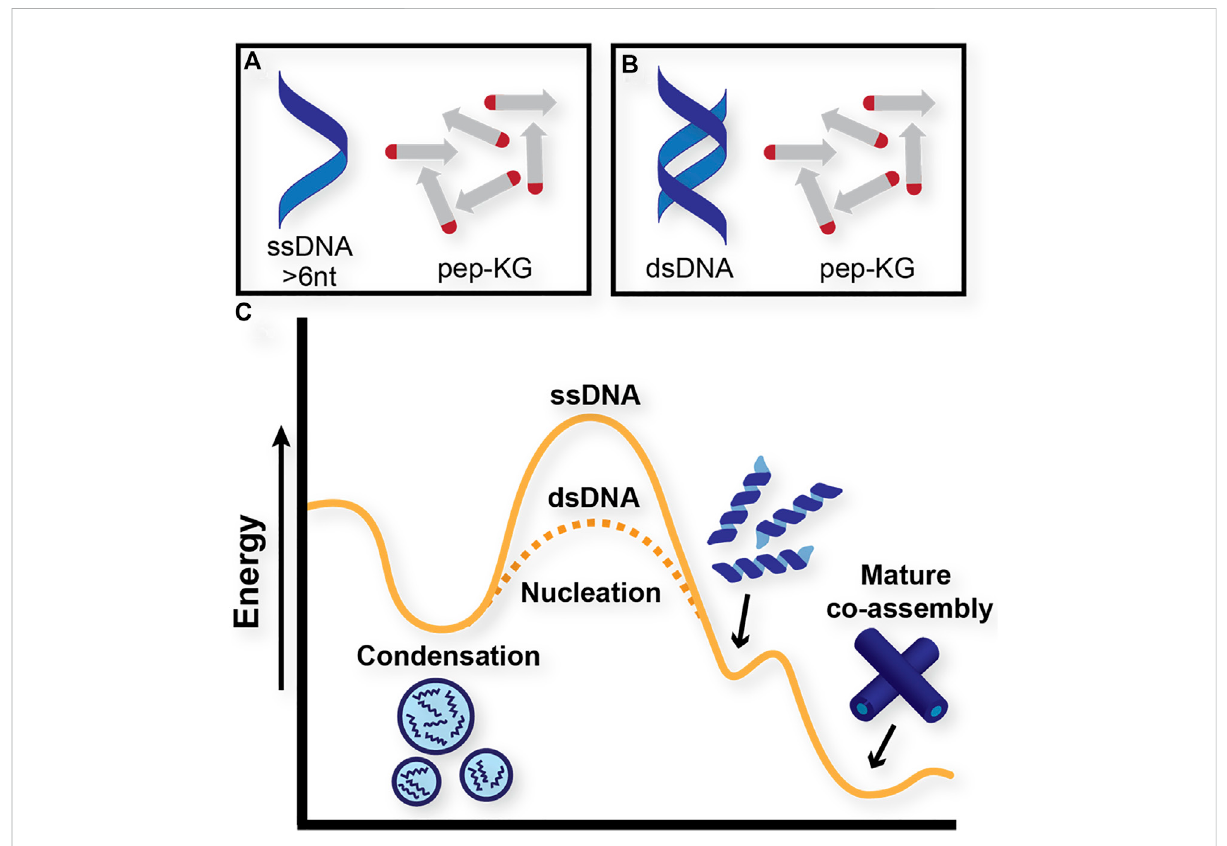
FIGURE 3 Proposed energy diagram of distinct pathways that Pep-KG may undergo through context-dependent co-assemblies. (A) and (B) denote Pep- KG assembly templated by ssDNA and dsDNA, respectively. Proposed energy diagram (C) illustrates dsDNA templates lower the energetics of nanotube assembly relative to ssDNA templates, as demonstrated by ThT fl uorescence